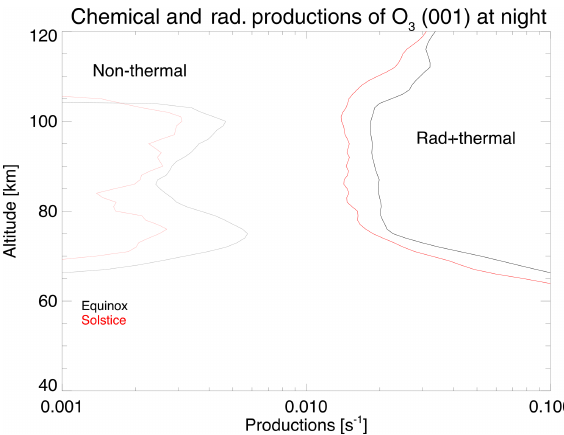
Figure 1. Specific production terms of the population of O 3 (001) in nighttime for 2 days typical of equinox (black) and solstice (red). Dotted lines are the specific non-thermal productions of O 3 ( v 3 = 1) (Eq. 6), and solid lines are the sum of the radiative absorption and thermal collisions, J Earth and p t in Eq.